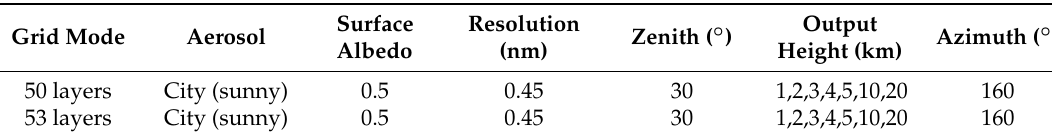
Table 3. Parameter settings of two different vertical grid modes.